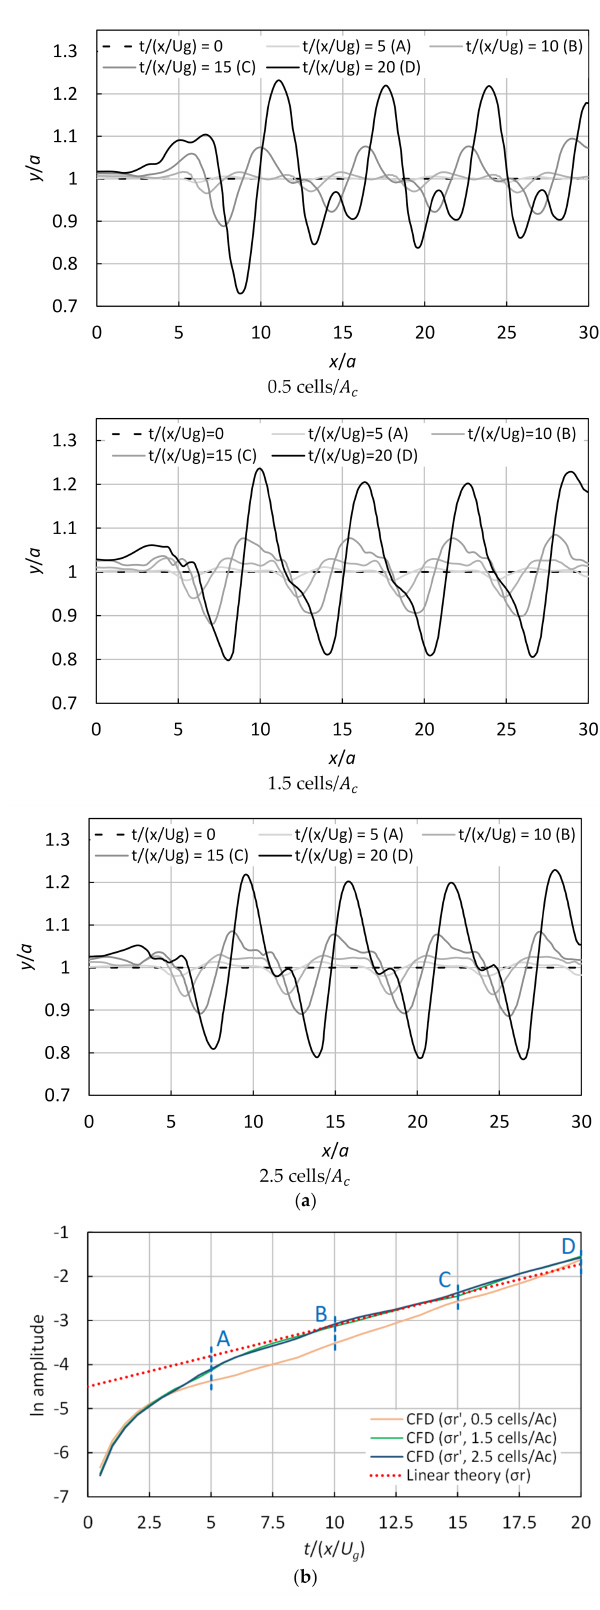
Figure 8. Time variation of the disturbance on the gas sheet surface for different numbers of cells (0.5, 1.5, and 2.5 cells/ A c ): ( a ) a visualization of the upper disturbed interface, for C α = 0 and We g = 2, and ( b ) a natural logarithm of the disturbance